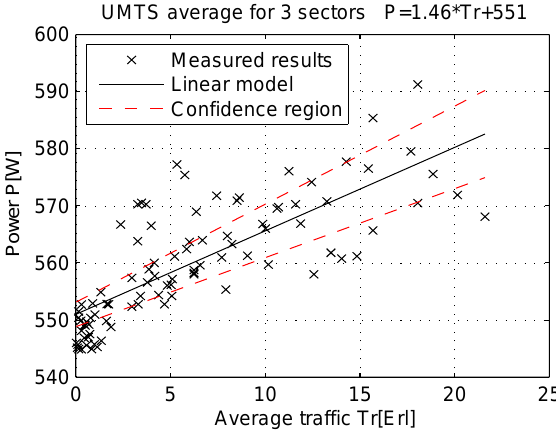
Figure 27. Power consumption model for UMTS BS rack (total measuring period).